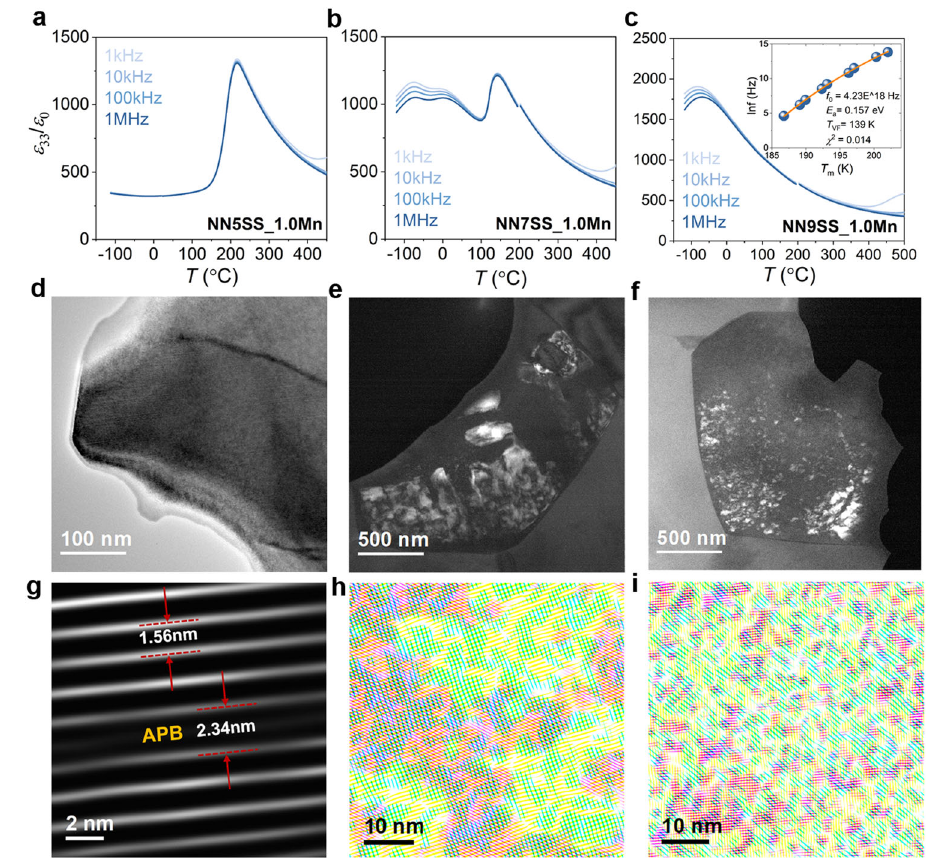
Fig.2|DielectricpropertiesandTEMcharacterizationofantiferroelectricsand relaxors. Temperature-dependent dielectric permittivity of the a NN5SS_1.0Mn, b NN7SS_1.0Mn, and c NN9SS_1.0Mn samples, measured at a frequency of 1kHz, 10kHz, 100kHz, and 1MHz. The inset in ( c ) demonstrates the fi tting of the fre- quency dispersion of the NN9SS_1.0Mn sample using the Vogel – Fulcher law. Domainmorphology,obtainedbythecircledsuperlatticere fl ectionsofFig.3a – cin ( d ) bright- fi eld (BF) and ( e , f ) corresponding centered dark- fi eld (CDF) modes. g – i Inverse fast Fourier transform (IFFT) images of the HRTEM images of